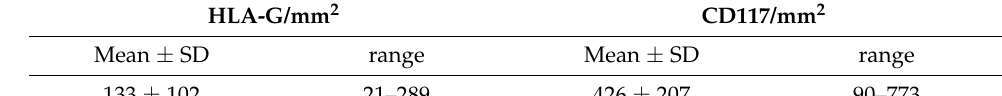
Table 7. Enumeration of HLA-G + and CD117 + cells/mm 2 in the kidney in renal fibrosis.